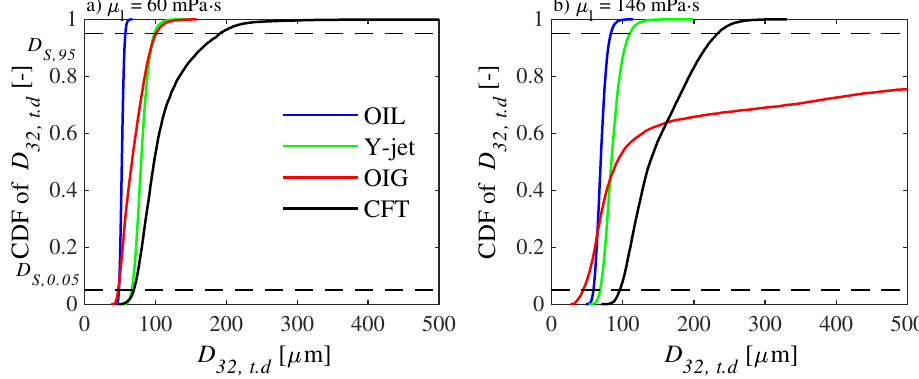
Figure 12. CDF of time-dependent drop sizes for spraying at GLR =